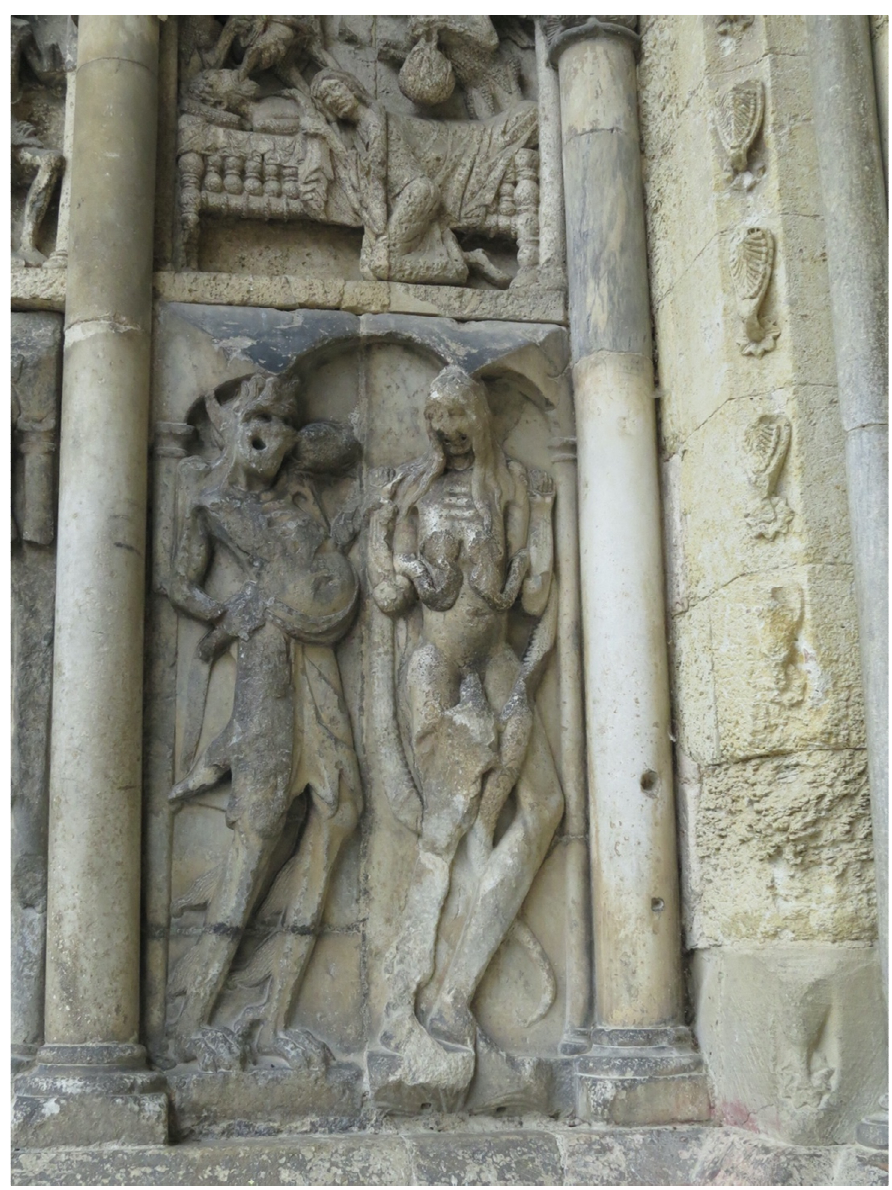
Figure 32. Avarice and Luxury, detail of west wall, south portal, Saint-Pierre-de-Moissac Abbey, 1115–1130, Moissac, Tarn-et-Garonne, Occitanie, France. ©Author.